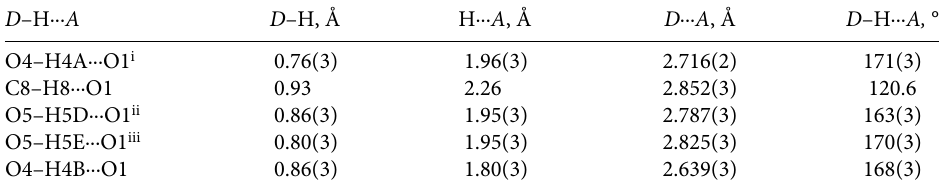
Table 3 . Hydrogen bonds for the title complex